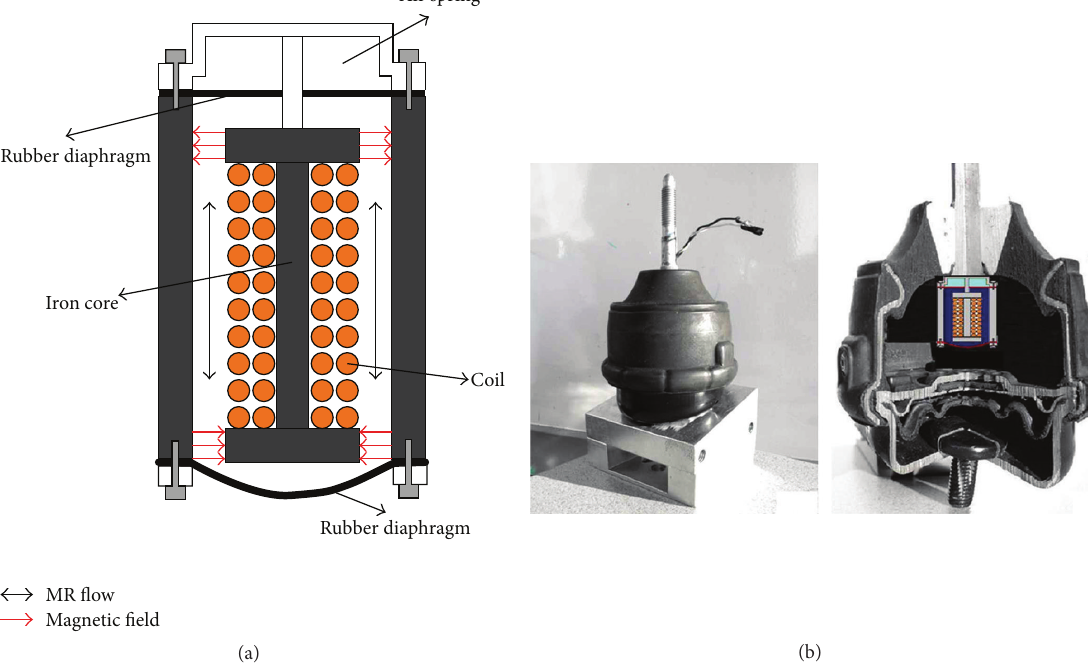
Figure 15: (a) Modified chamber and (b) MR mount with the modified chamber.